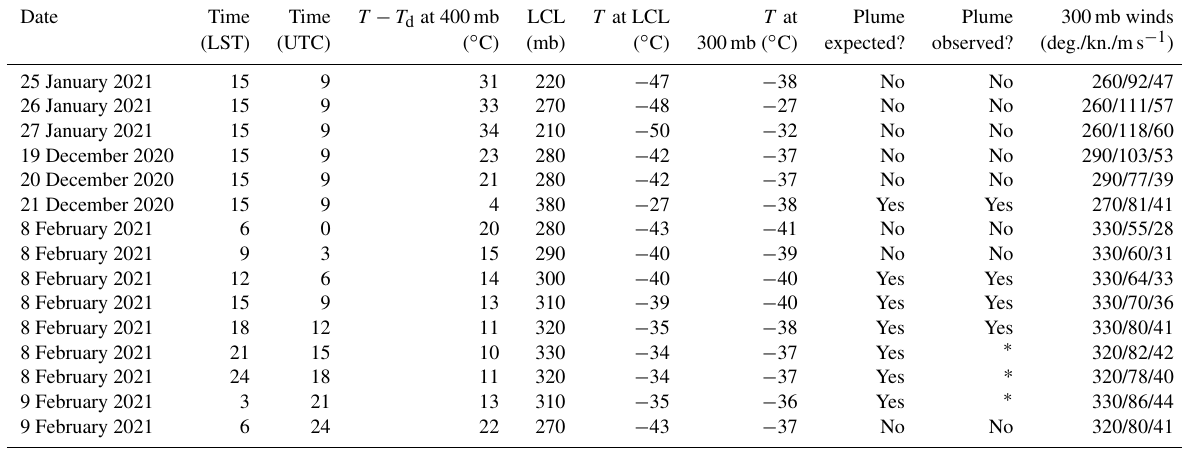
Table 1. Air parcels lifted from the 400mb level, approximate pressure at the base of the Everest summit pyramid, to their condensation levels (LCL) using gdas1 profiles for Phortse, Nepal (27.84 ◦ N, 84.75 ◦ E). The approximate pressure at Everest’s summit is